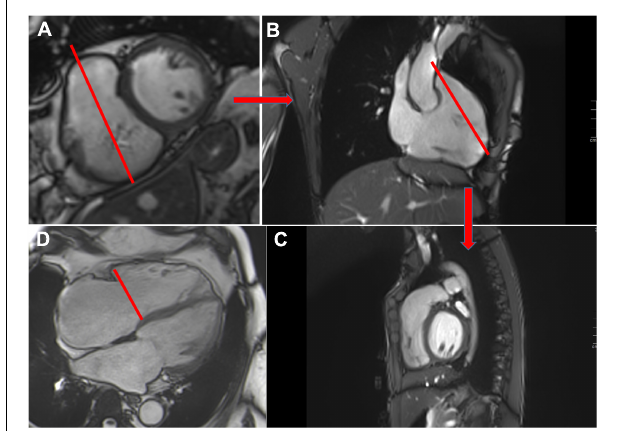
FIGURE 6 | Cardiovascular magnetic resonance planes used for evaluation of the right ventricle. Short axis view (A) , 3-chamber view (B) and RVOT (C) . Example of tricuspid annular measurement in the 4-chamber view (red line) (D)